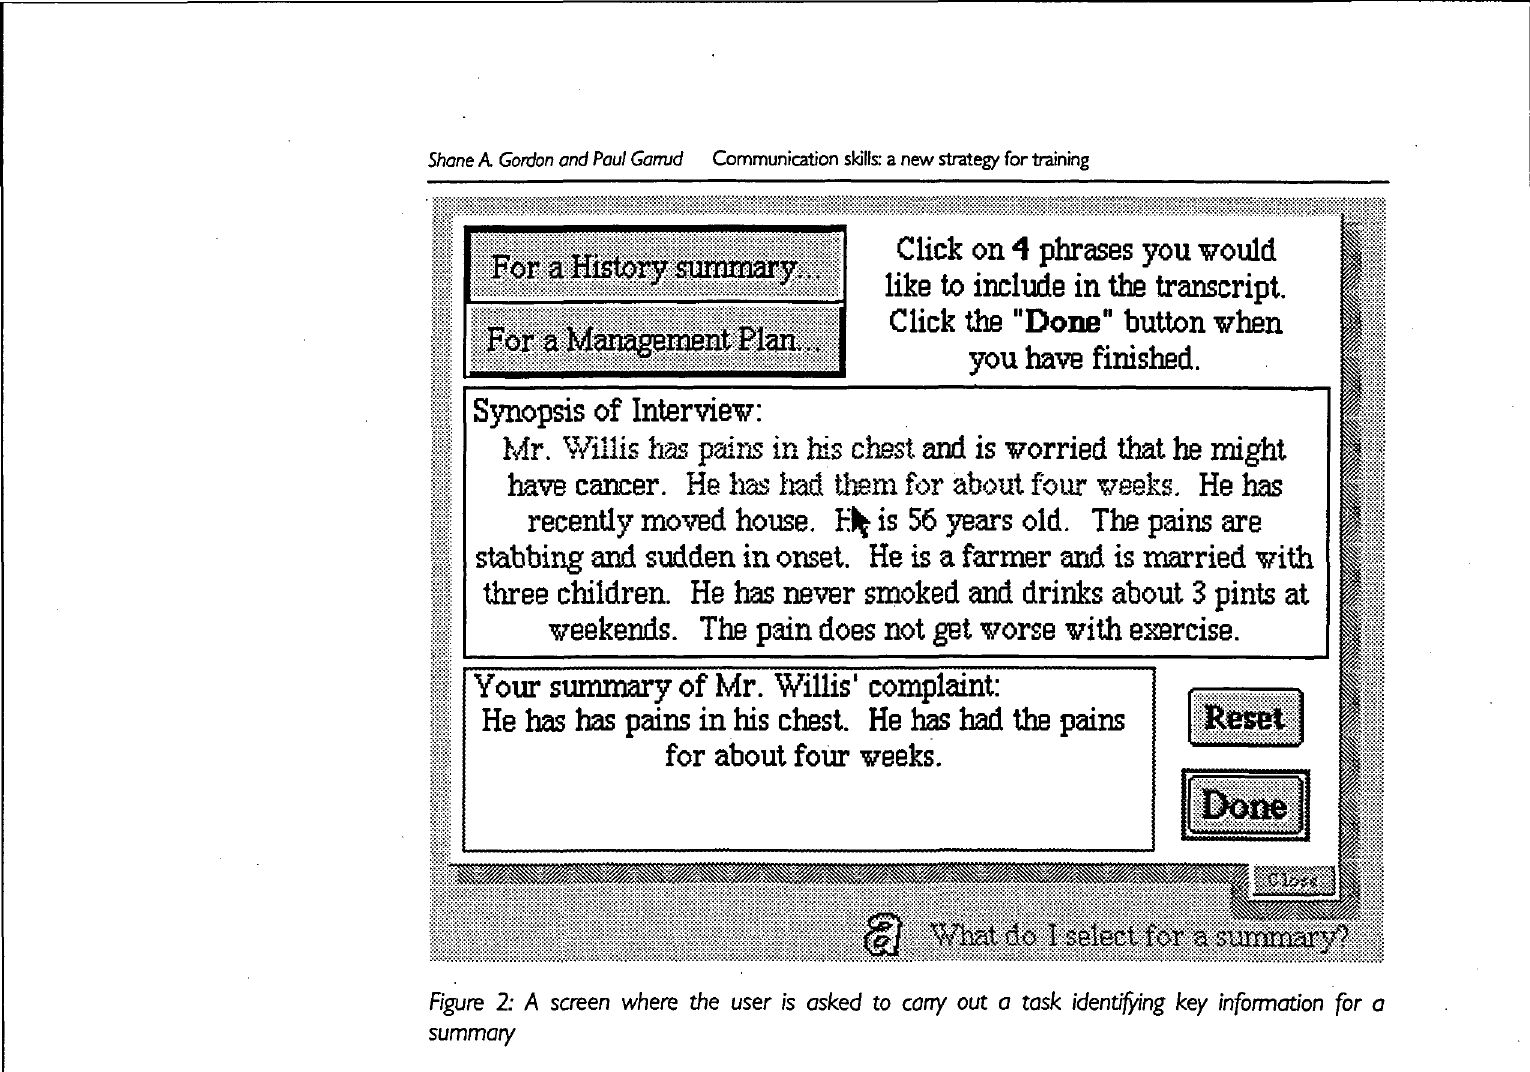
Figure 2: A screen where the user is asked to carry out a task identifying key information for a